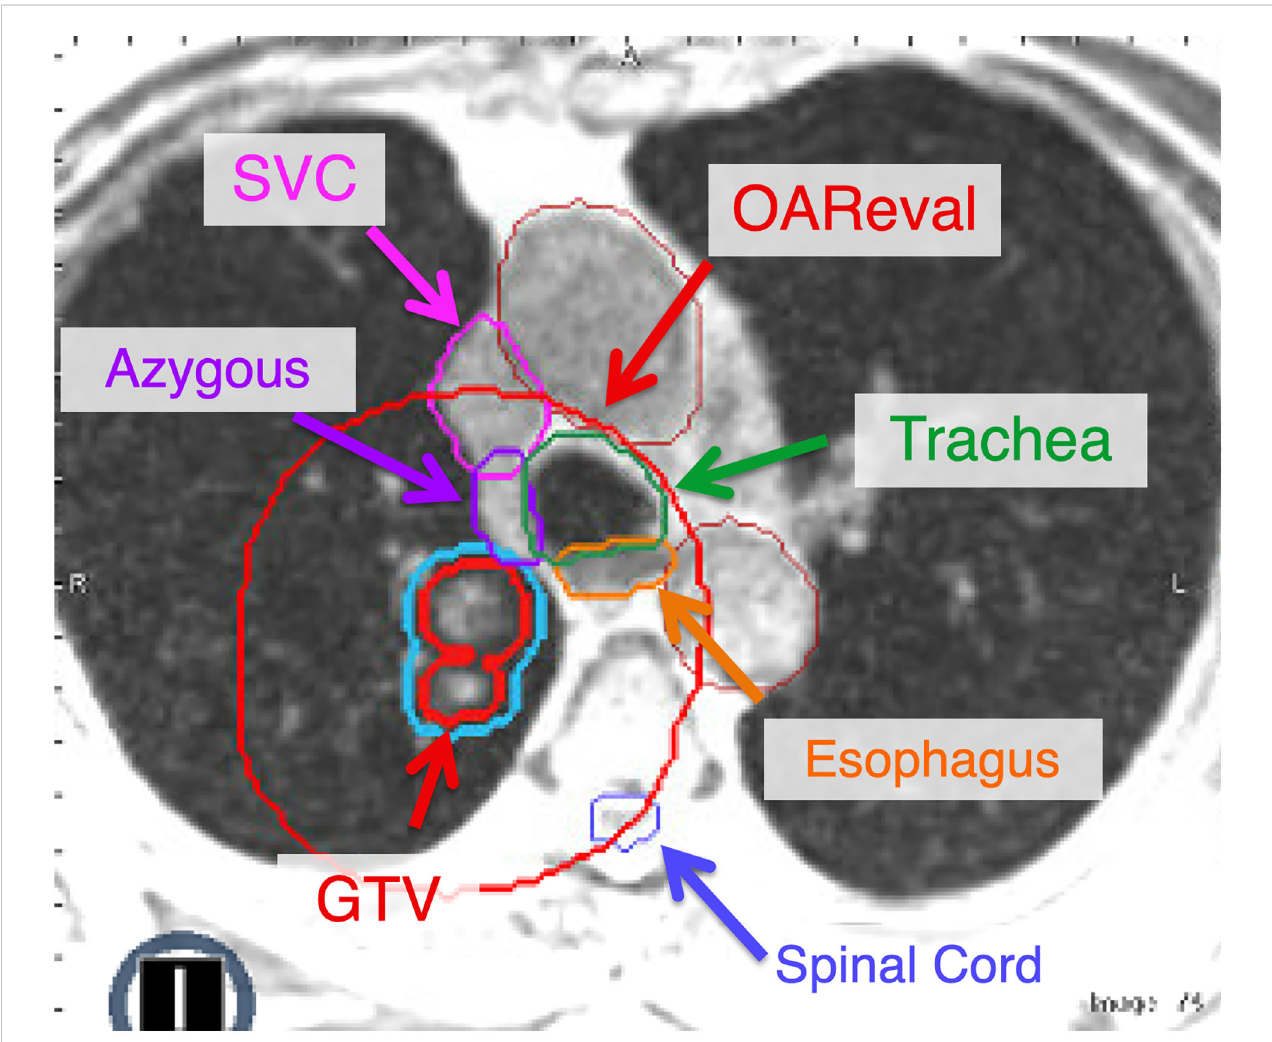
FIGURE 3 The OAReval structure is generated by taking the PTV and expanding 2 cm sup/inf and 3 cm radially. Central and ultracentral structures should be contoured to ensure inclusion of the wall of critical structures such as the esophagus and airways (i.e., trachea, mainstem). The focus of adaptive recontouring will be on OAR within the OAReval structure. However, it is critical to ensure an appropriate spinal cord contour is present. At our institution, we recommend contouring all great vessels (Aorta, SVC, etc.). However, we also include the brachiocephalic and azygous if they fall within the OAReval to ensure that they do not receive doses above 105% of the